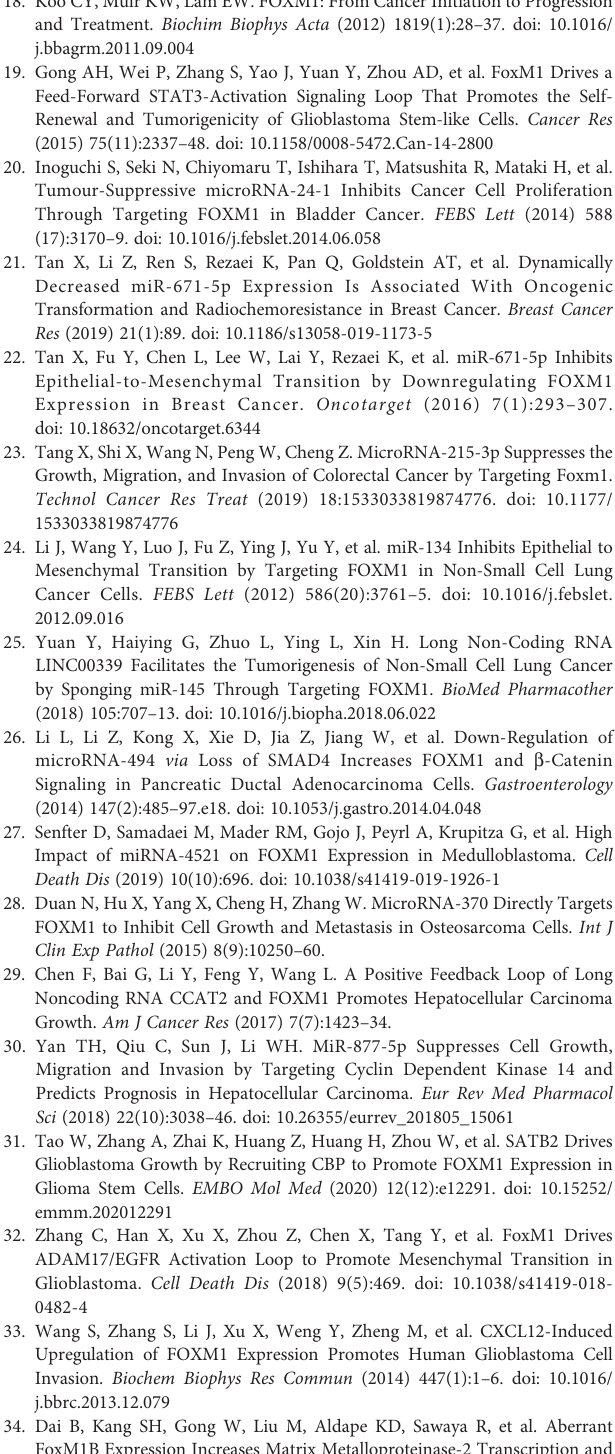
Supplementary Figure 1 | CCK-8 assays were performed after cells were cotransfected with different vectors. (A) U251-MG cells co-transfected with circPIK3C2A-OE and miR-877-5p mimics was reduced compared withthose in the circPIK3C2A-OE group. (B) T98G cells co-transfected with circPIK3C2A-KD and